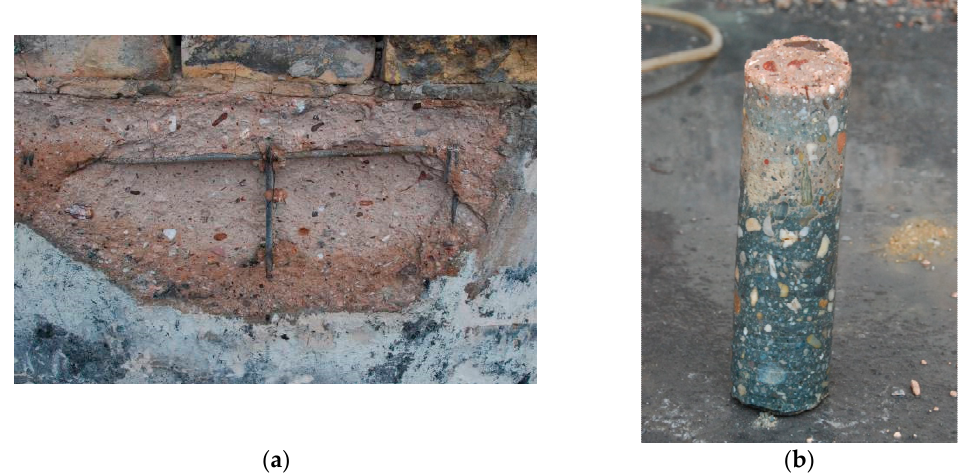
Figure 3. Concrete colour change after the fire. ( a ): concrete surface after cover splitting ( b ): colour change over the thickness based on a core sample.